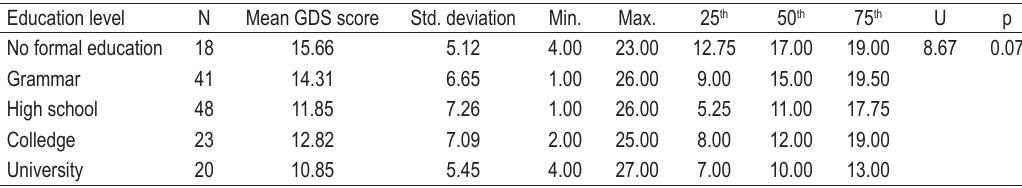
FIGURE 4. Frequency and the distribution of GDS scores according to marital status TABLE 1 . The impact of education on GDS score